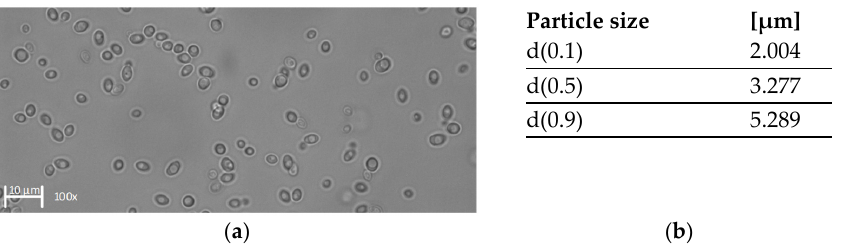
Figure 2. Characterization of K. lactis cells after harvest. ( a ) Image of K. lactis in 150 mM citrate- phosphate buffer (pH 5) captured by light microscopy at 100× magnification. ( b ) Calculated d-values based on the volume related particle size measurement.